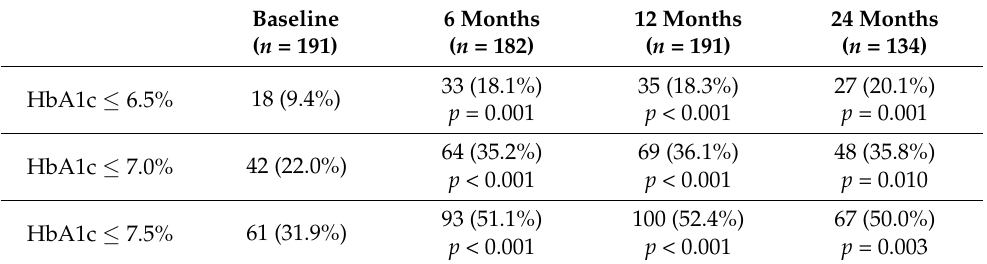
Table 2. Number of patients ( n /%) who achieved different HbA1c goals over time. Baseline